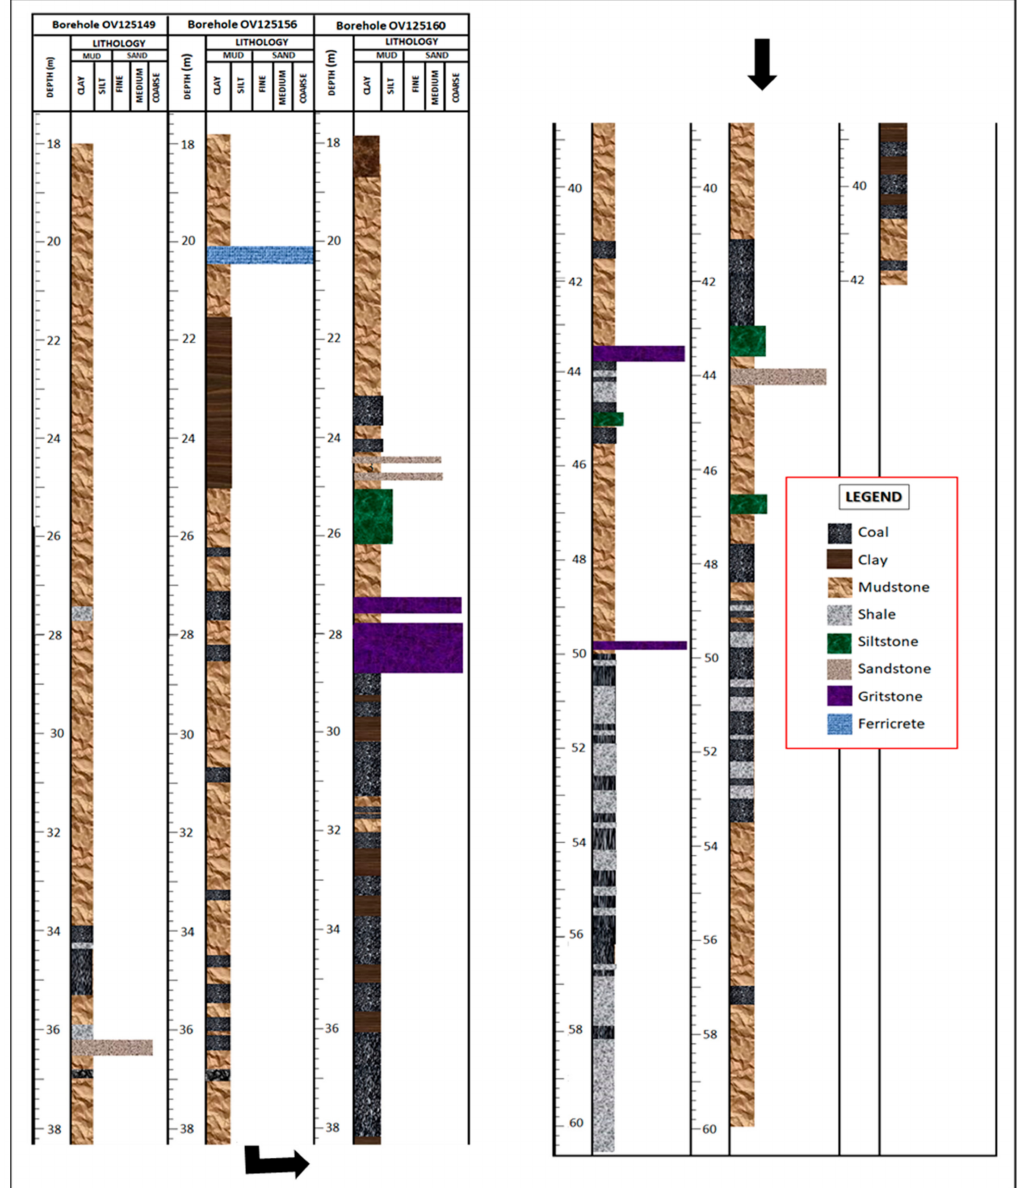
Figure 4. Stratigraphy of the Madzaringwe Formation in boreholes OV125149, OV125156, and OV125160. Note: No core recovery from the surface down to a depth of 18